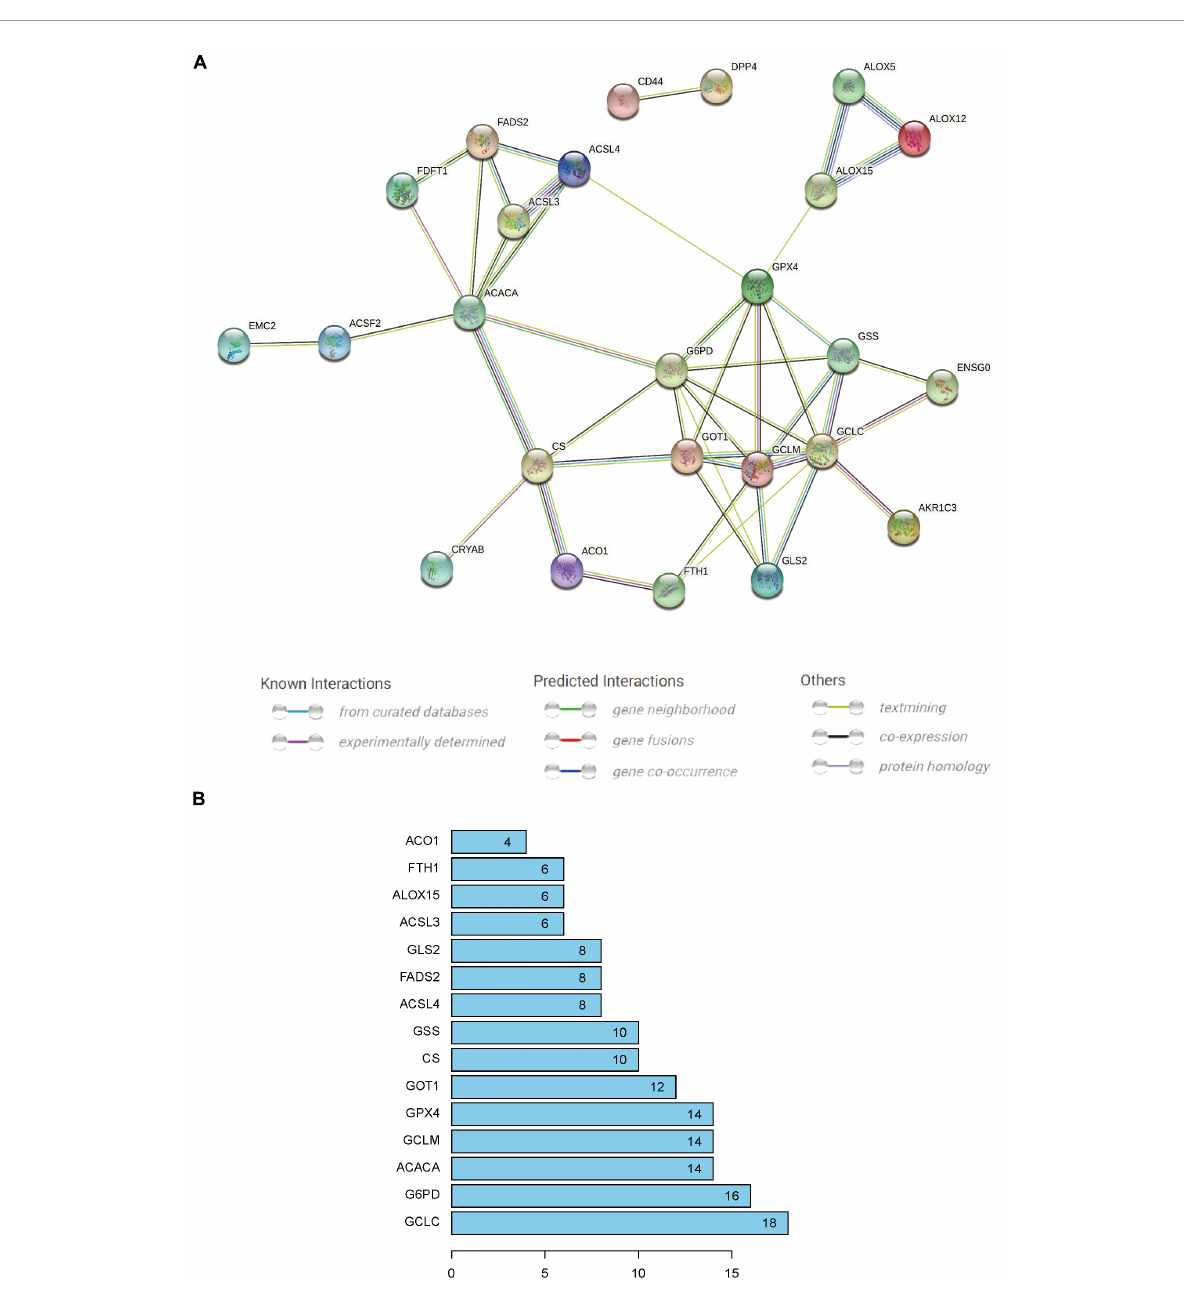
FIGURE5 (A) Protein–protein interaction network generated by STRING database analysis indicating direct and indirect associations among 29 crucial FRGs. (B) Fifteen significant nodes of the PPI network were screened using an interaction score > 0.4; these were the most widely connected and are sorted by the number of connected